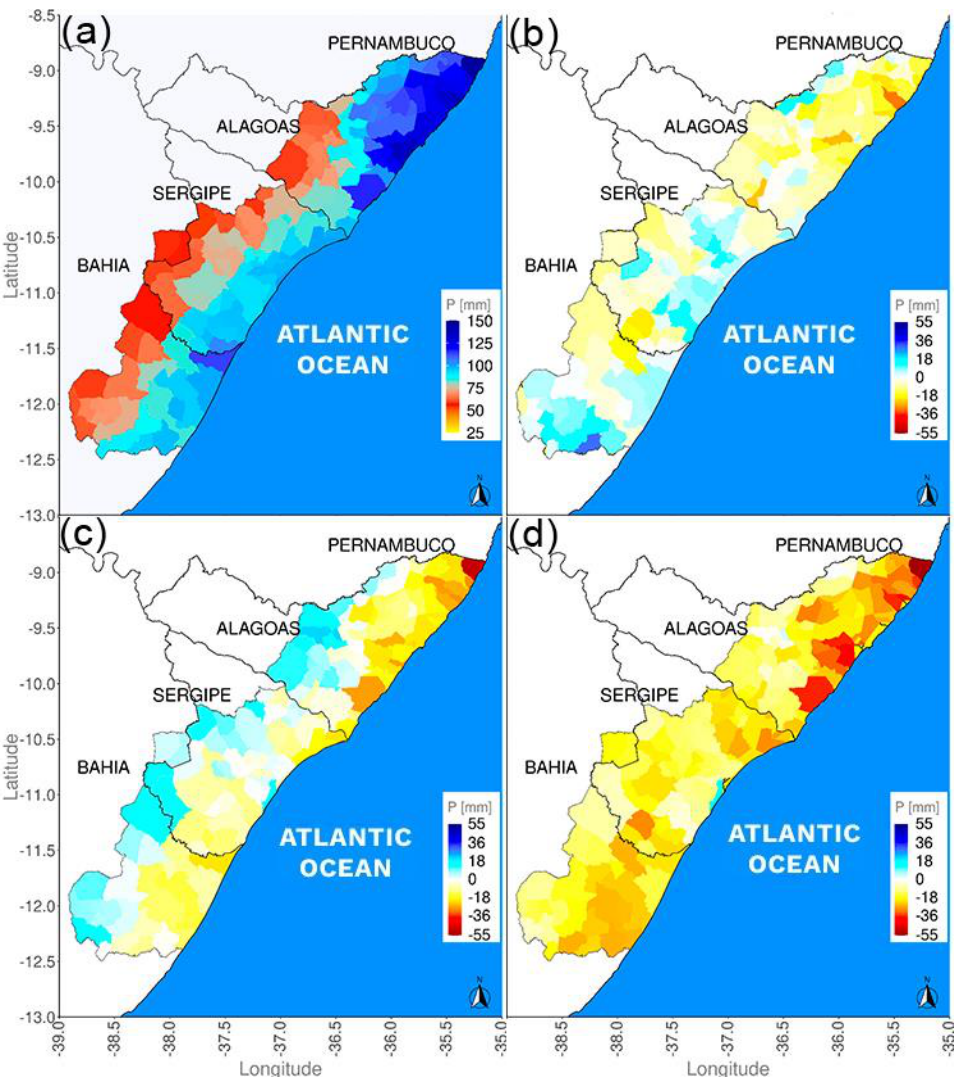
Figure 5. Annual monthly average of accumulated precipitation as per data from MERGE ( a ) and the differences between that and the corresponding values obtained from CHIRPS (MERGE minus CHIRPS) ( b ), ERA5 (MERGE minus ERA5) ( c ), and ERA5Land (MERGE minus ERA5Land) ( d ). The precipitation scale (P) in figures 5b – d, varies from − 55 to 55 mm.